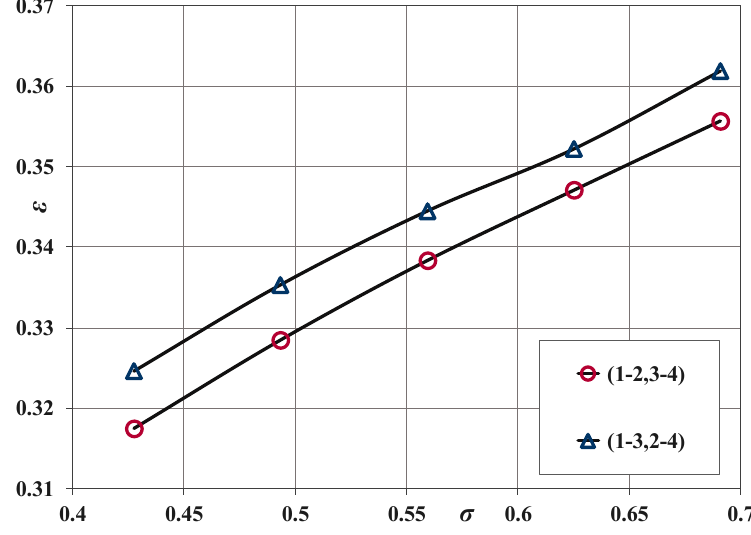
Figure 11. Thermal e ff ectiveness versus dimensionless shank spacing.